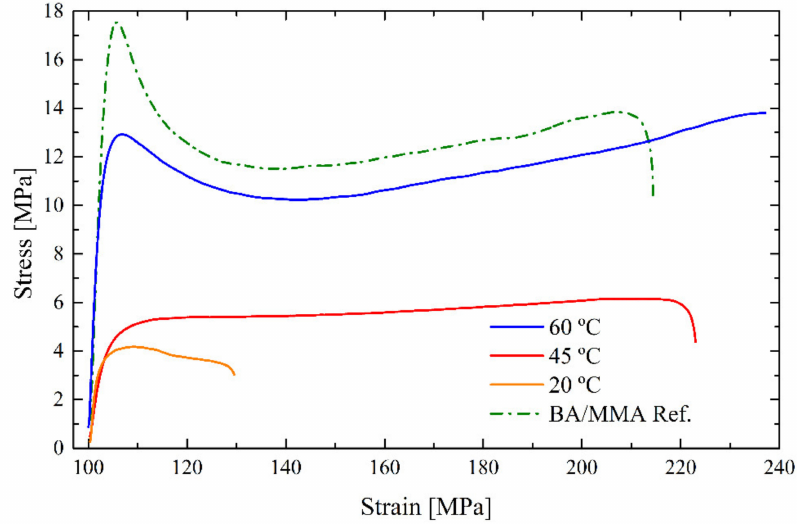
Figure 3. Stress–strain curves for films made with the ITA latex annealed 24 h at di ff erent temperature, and RH = 55%, compared to the reference (REF) latex dried at 60 ◦